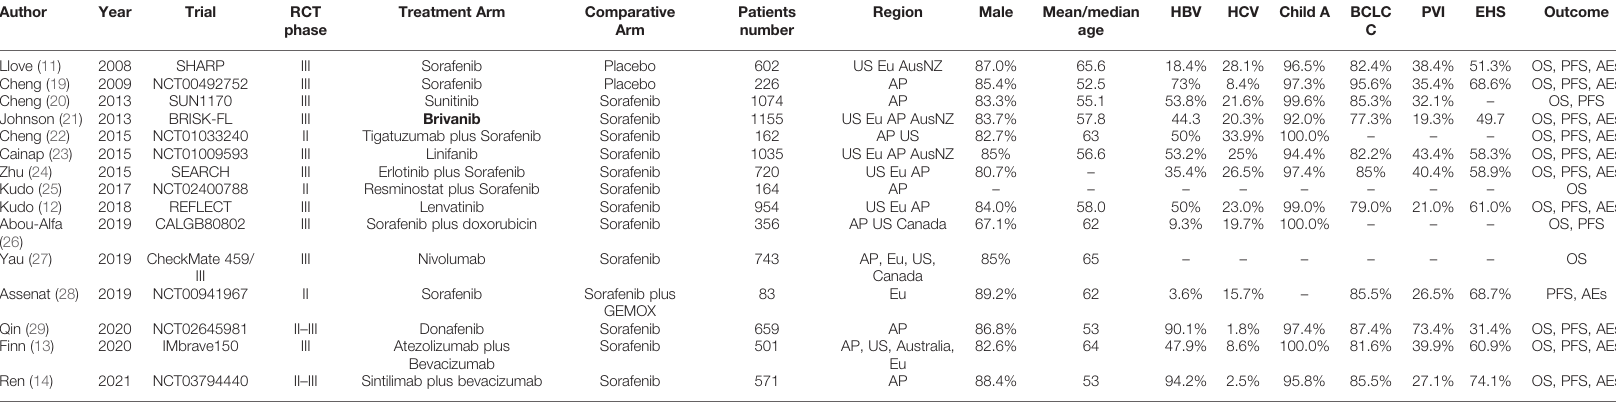
TABLE 1 | Characteristics of the included trials.